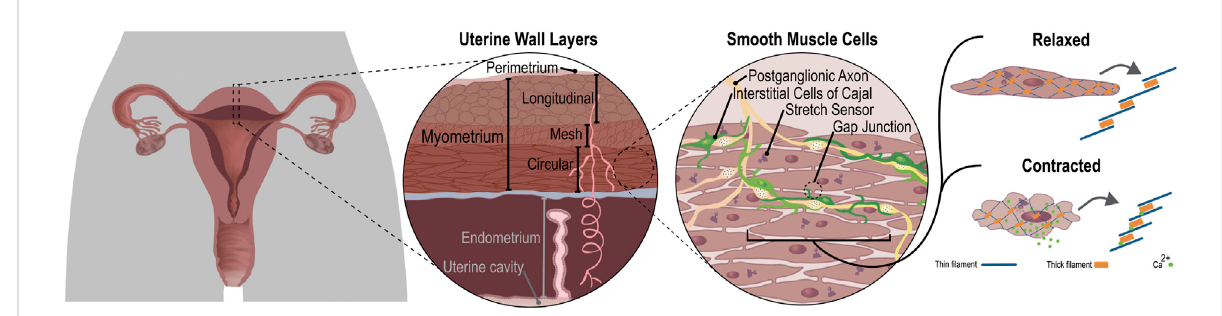
FIGURE 7 The multiple scales of uterine structure, ranging from the whole organ (left) to tissue layers, intra-tissue organization and individual cells (right). Characterizing uterine behavior entails teasing out dynamical connections between spatial and temporal scales such as myometrial responses to mechanical distensions shaped by tissue layers organized into contractile fi bers. In turn, fi bers comprised of individual cells coupled with neighbors via gap junctions or stretch activated sensors drive overall organ-wide responses from cell-level ion channel activity, themselves subject to hormonal in fl uence either by endogenous evolution of concentrations up to parturition or arti fi cially by clinical stimulation. Each scale individually presents mathematical modeling challenges, further ampli fi ed their integration into a whole, realistic and tractable representation of the entire organ.